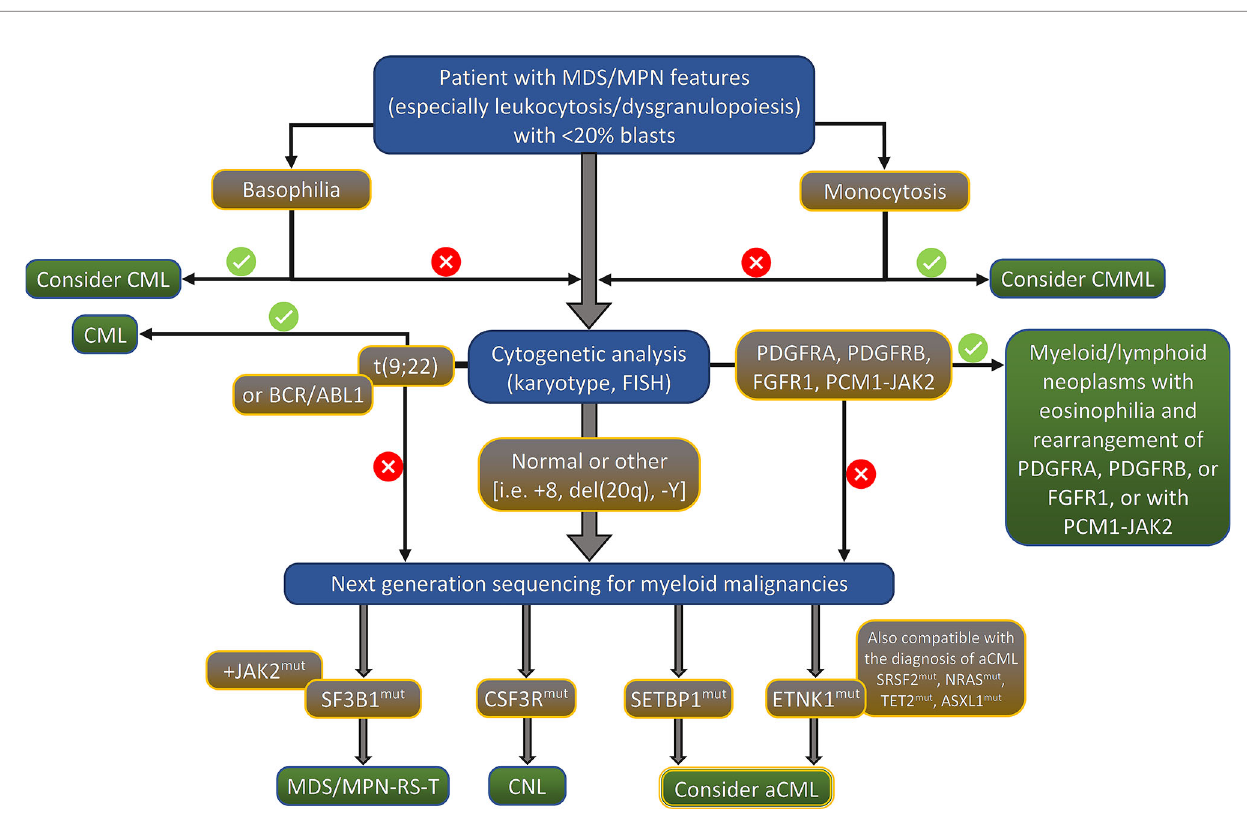
FIGURE 1 | Proposed algorithm for the diagnosis of aCML. MDS/MPN, myelodysplastic syndrome/myeloproliferative neoplasm; CML, chronic myeloid leukemia; CMML, chronic myelomonocytic leukemia; FISH, fl uorescent in situ hybridization; RS, ring sideroblasts; T, thrombocytosis; CNL, chronic neutrophilic leukemia; aCML, atypical chronic myelogenous leukemia, BCR/ABL1